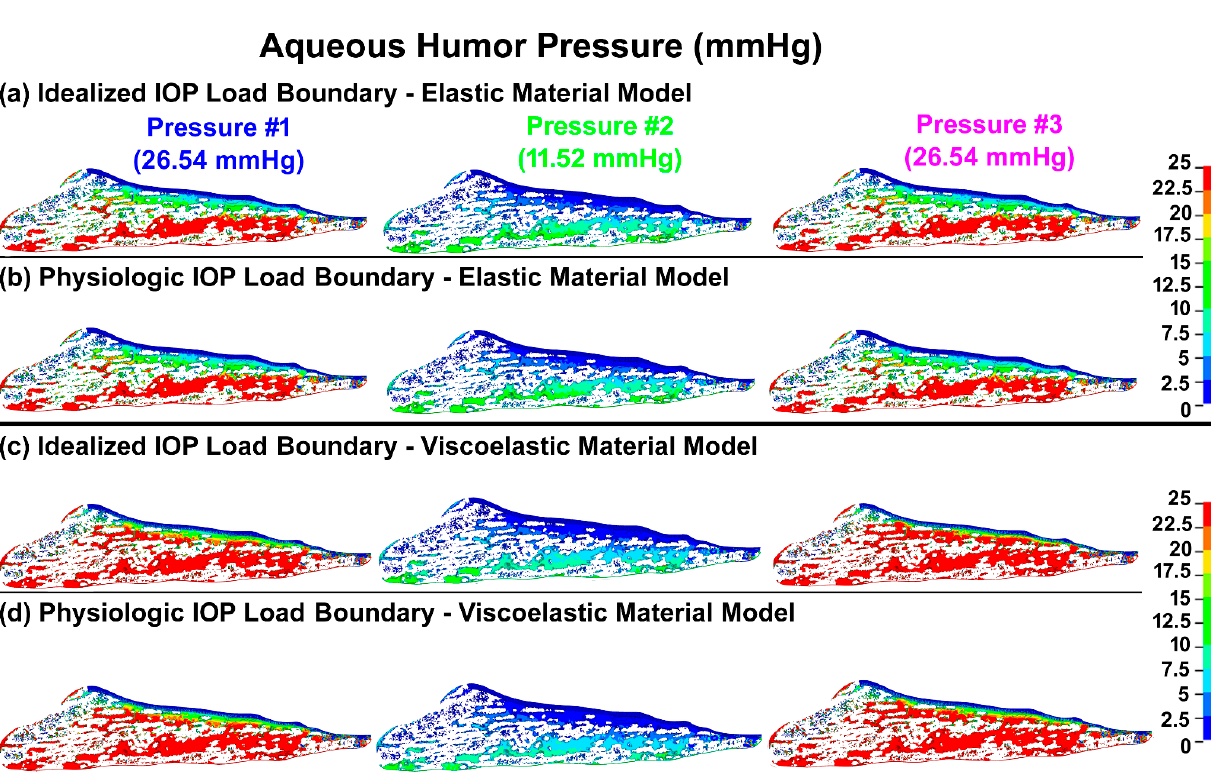
Figure 6. The maximum shear strain in the TM/JCT/SC complex with ( a ) idealized IOP load boundary (elastic material), ( b ) physiologic IOP load boundary (elastic material), ( c ) idealized IOP load boundary (viscoelastic material), and ( d ) physiologic IOP load boundary (viscoelastic material) at three different IOPs. The pressure in the aqueous humor across the TM/JCT/SC complex with idealized and physiologic IOP load boundary and elastic and viscoelastic material models at three different pressures is shown in Figure 7.